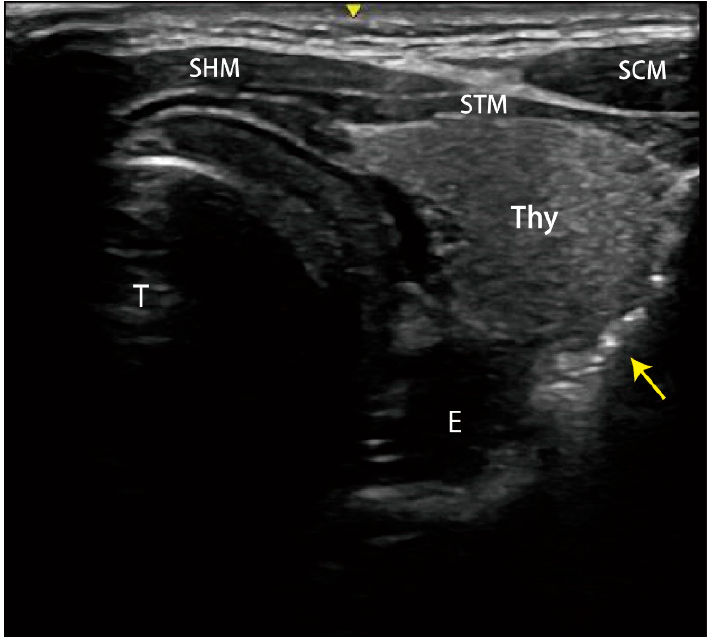
Figure 1. Point-of-care ultrasound found the free air (yellow arrow) in the soft tissue of the neck with ring-down artifacts along the esophageal tract. STM: sternothyroid muscle; SHM: sternohyoid muscle; SCM: sternocleidomastoid muscle; E: esophagus; T: trachea; Thy: thyroid